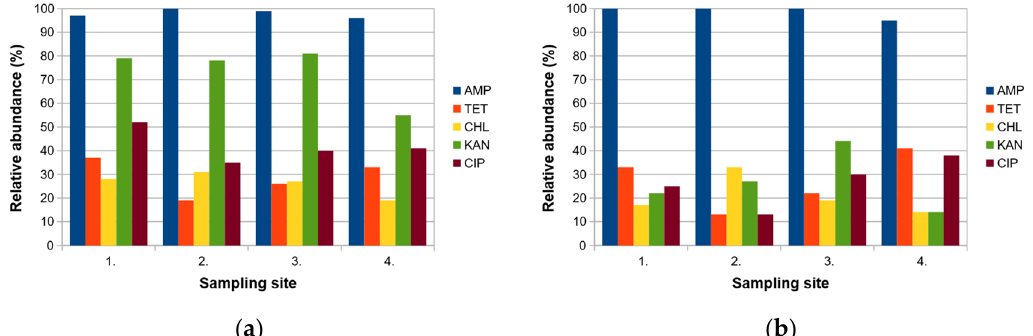
Figure 2. The prevalence of antibiotic-resistant strains within cultivable bacterial community ( a ) and Acinetobacter spp. ( b ) in different stages of the wastewater treatment process in Kokšov-Bakša (Košice, Slovakia). AMP—ampicillin, KAN—kanamycin, TET—tetracycline, CHL—chloramphenicol, CIP—ciprofloxacin. 1.—inflow, 2.—mechanical wastewater treatment, 3.—biological wastewater treatment, 4.—outflow.